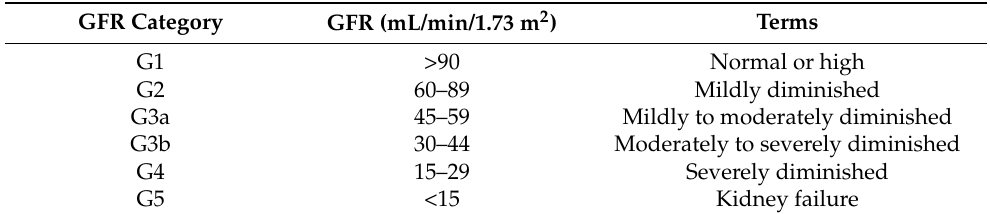
Table 2. GFR categories in